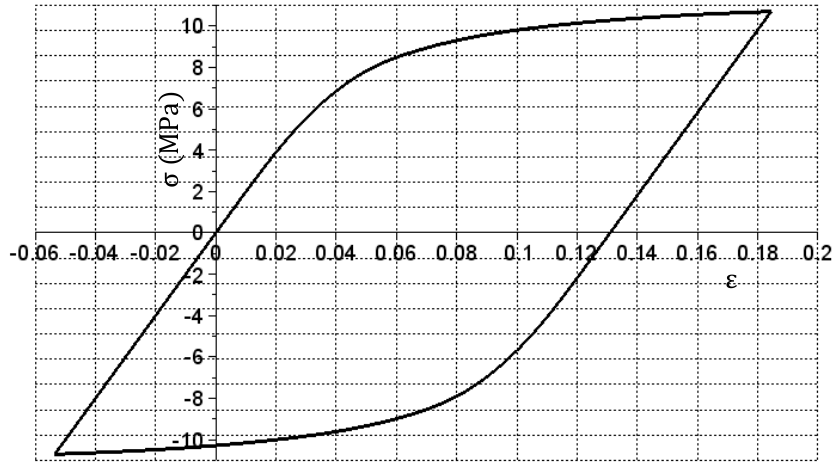
Figure 13. The σ ( ε ) relation obtained during the tension and subsequent compression sample simulation. Figure 13. The σ(ε) relation obtained during the tension and subsequent compression sample As it can be seen in Figure 13, a hysteresis loop graph was obtained. The shape results simulation. from the adoption of the symmetry of values in the E p matrix. Precise loop closure at the ( 0.0 ) point additionally indicates high accuracy of the algorithm used. The next analyzed issue is related to the tension of the system of three connected bars shown in Figure 14.